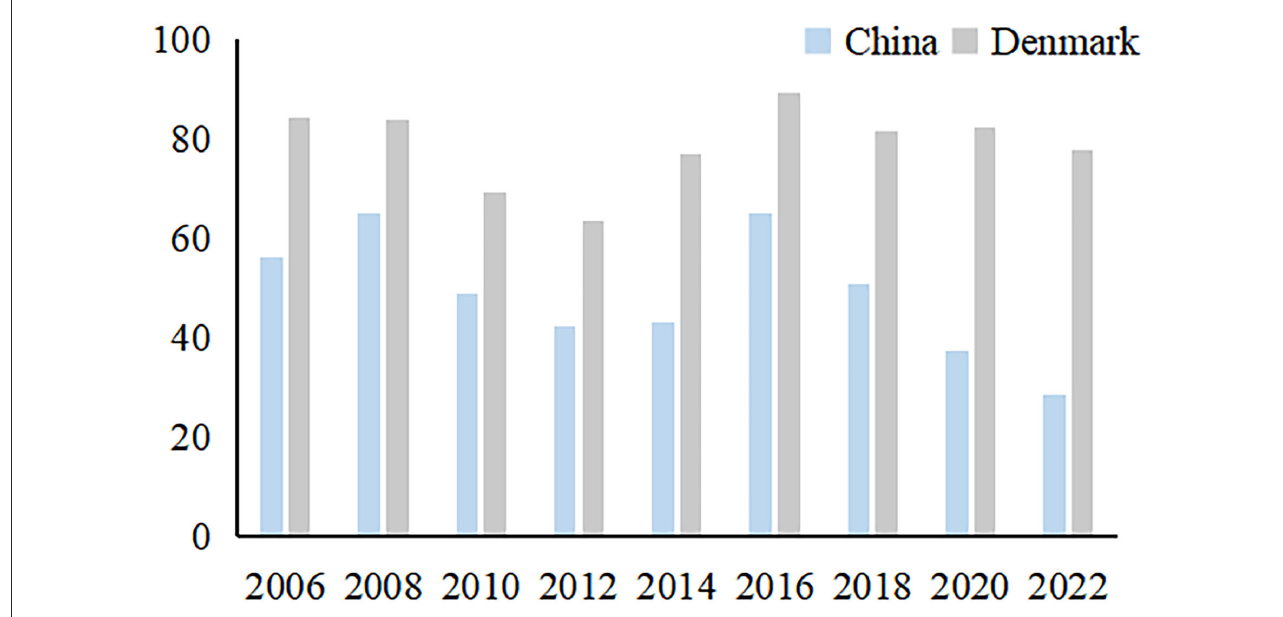
FIGURE1 Comparison of EPI between China and